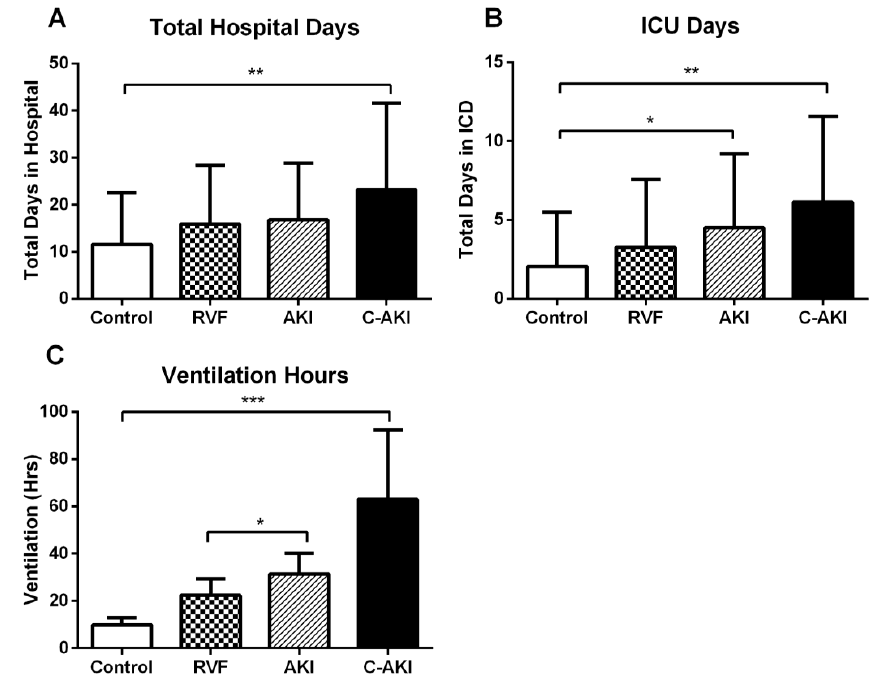
Figure 4. Lengths of stay in hospital ( A ) and ICU ( B ) and duration of mechanical ventilation ( C ) in patients who developed postoperative acute kidney injury (AKI), right ventricular failure (RVF), congestive AKI (c-AKI), and controls. Data expressed mean ± SD. * p < 0.05, ** p < 0.01, *** p < 0.001.